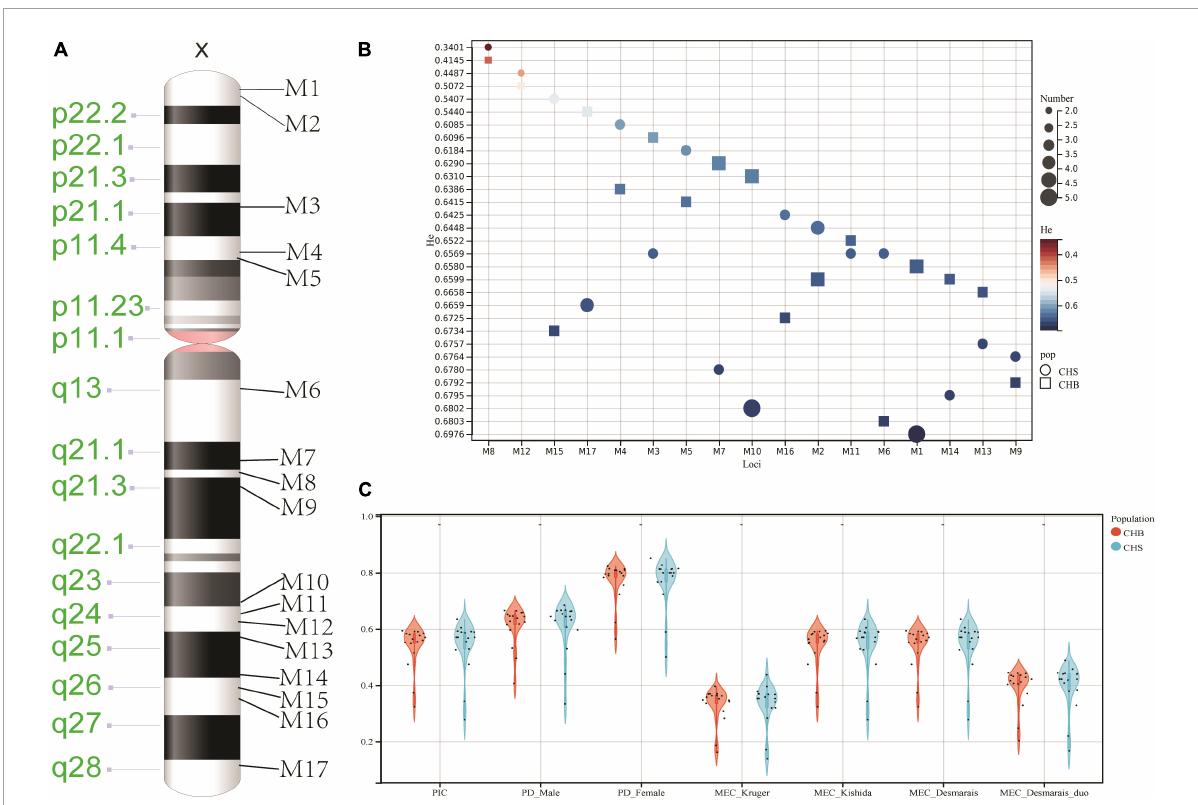
FIGURE1 Physical locations (A) , genetic diversities (B), and forensic efficiency evaluations (C) of 17 X-chromosomal Multi-InDels in Beijing Han (CHB) and Southern Han (CHS) populations. For genetic diversities, different colors represented different expected heterozygosity (He) values: red and blue denote small and large He values, respectively; the size of shape is proportional to the number of alleles observed in each